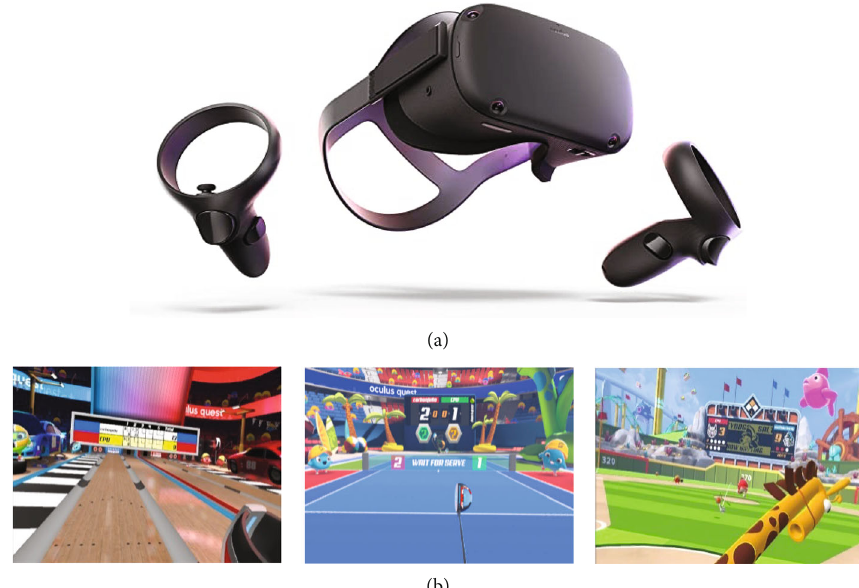
Figure 1: Tools and scenario used in intervention: (a) Oculus Quest with a controller and (b) three types of sport scenarios in Sport Scramble. Bowling, tennis, and baseball (left to